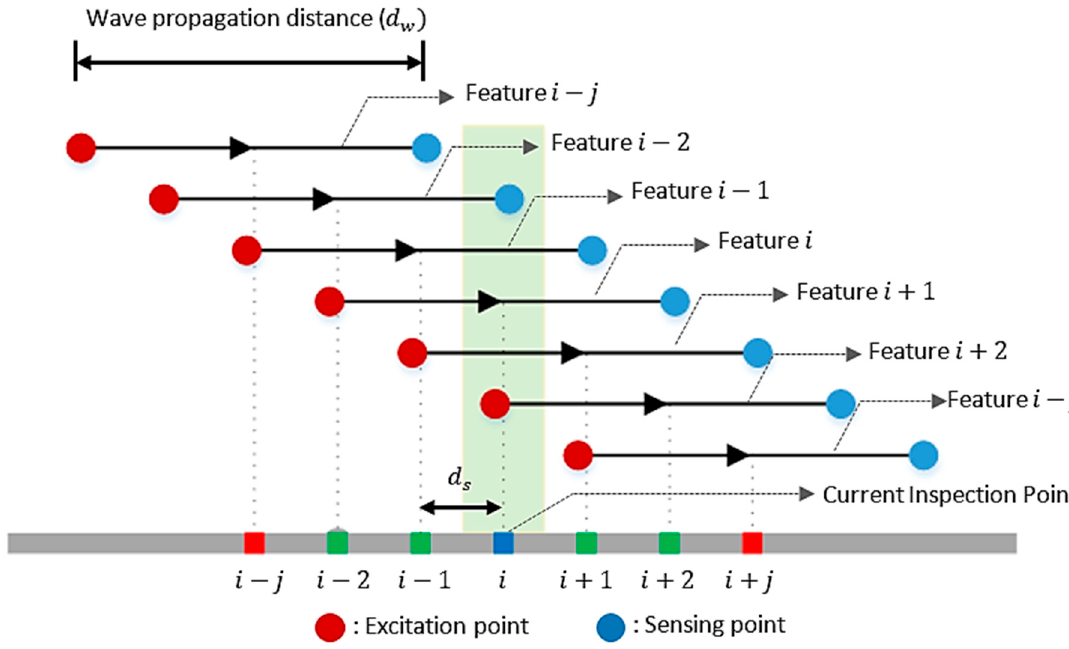
Figure 3. Calculation of damage index (DI) for the i th inspection point in the scanning area [25].